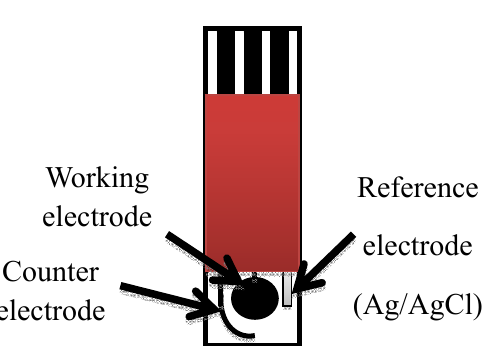
Figure 1. Screen printed